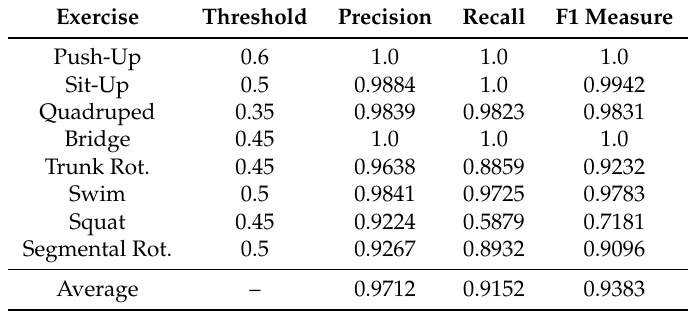
Table 3. Selected thresholds and calculated metric for repetition counting in the single-user case.